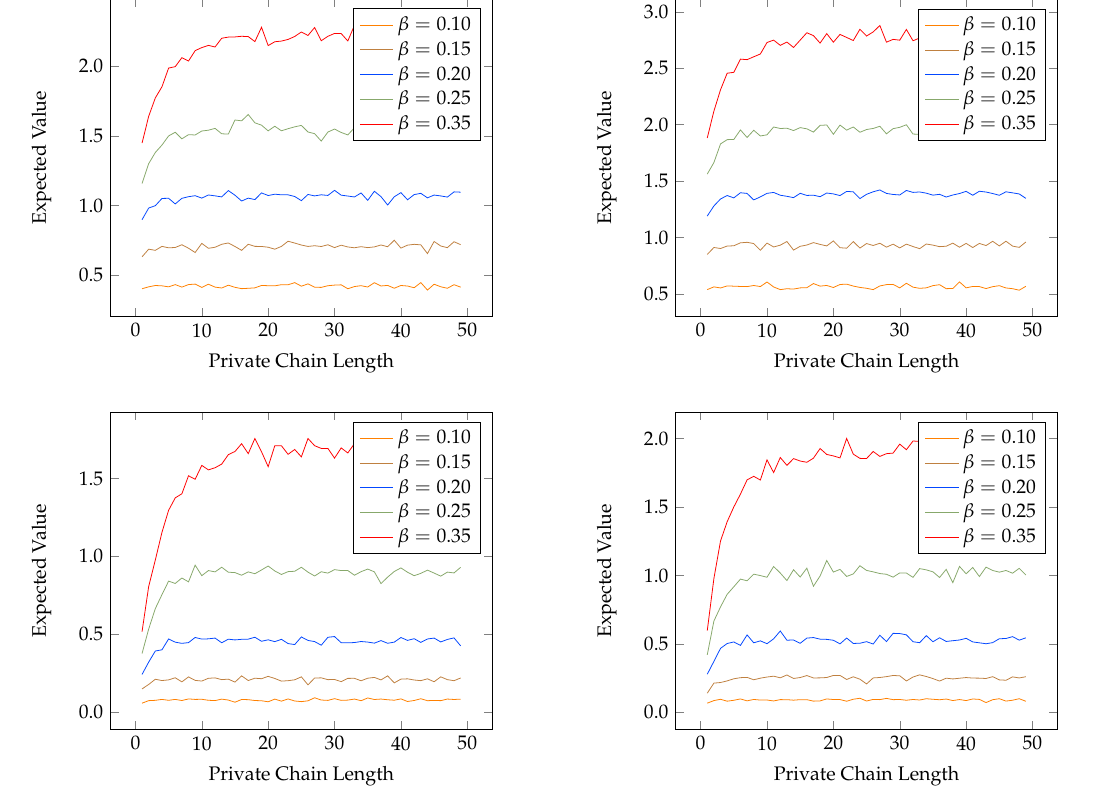
Figure 4. Results for threshold experiment. The first two graphs are obtained by considering that a successful attack was due to the fact that the attacker was able to create a chain with a length equal to the main chain. The last two (bottom) consider a successful attack a private chain one block longer than the main chain. Graphs on the left have σ = 1, for the graphs on the right, σ =